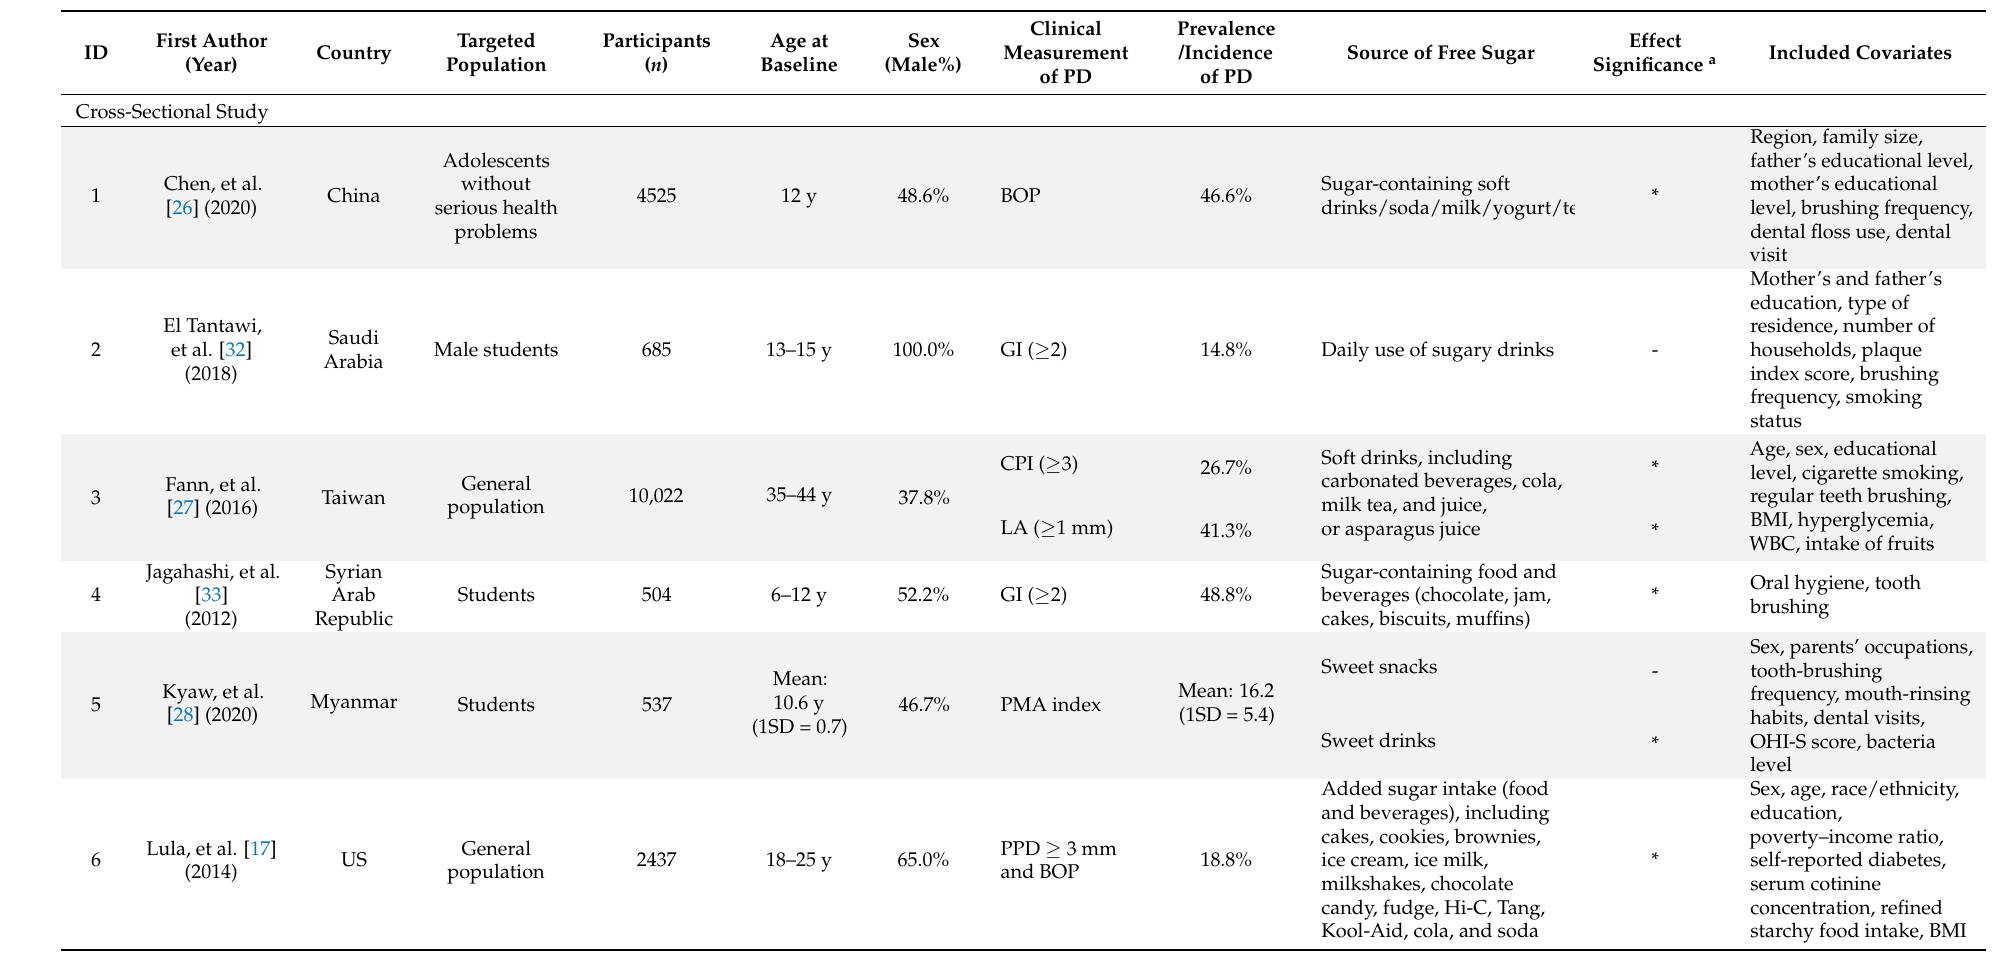
Table 1. Descriptive characteristics of included